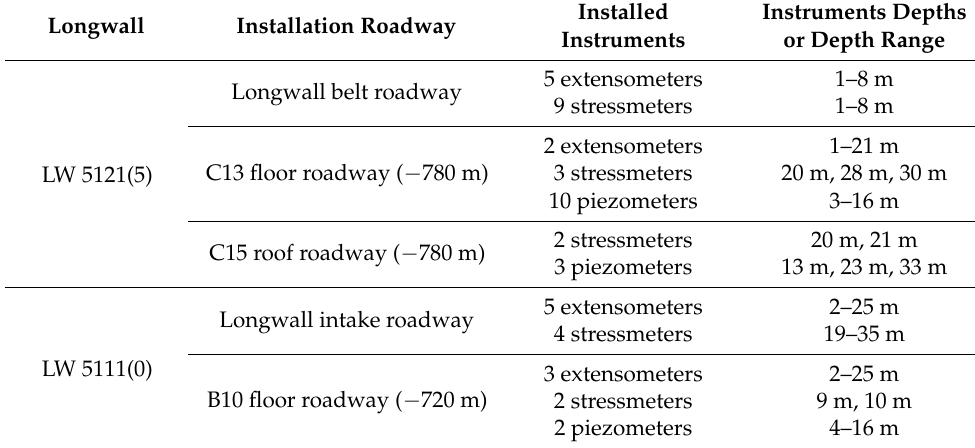
Figure 2. The designed monitoring plan at ( a ) LW 5121(5) and ( b ) LW 5111(0). Note that the number and positions of the instruments were slightly altered due to site conditions. Table 1. Installed instruments in roadways surrounding LW 5121(5) and LW